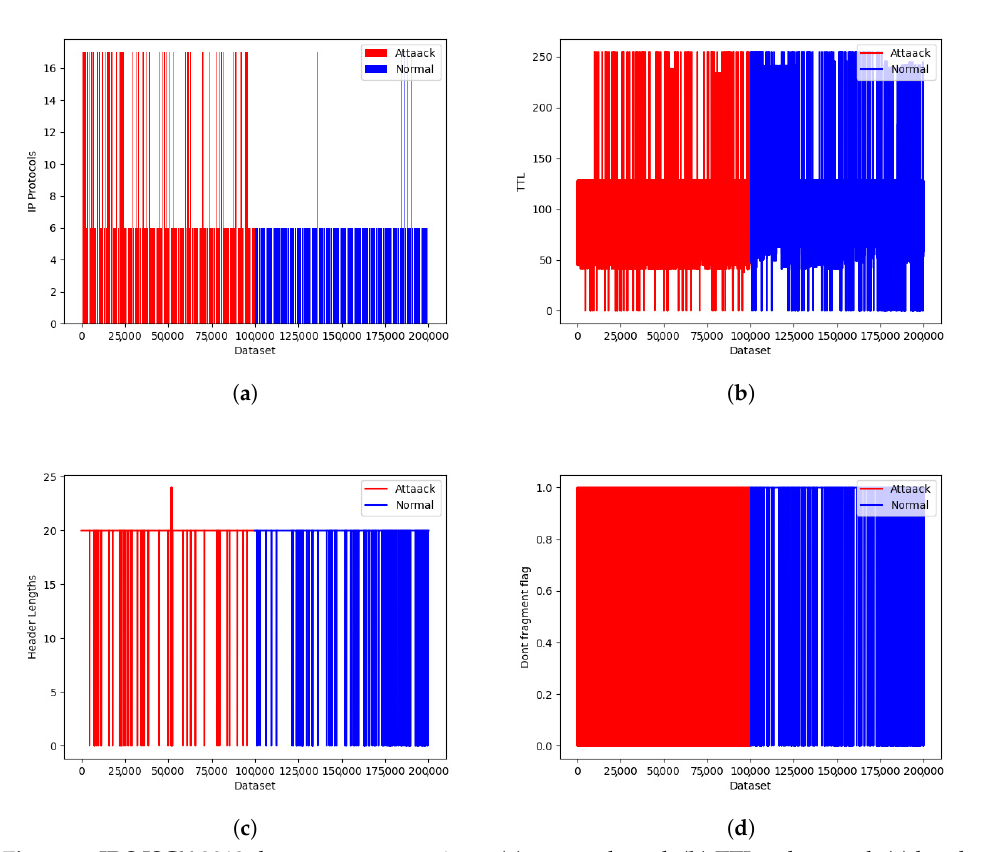
Figure 7. IDS ISCX 2012 dataset representations: ( a ) protocol used; ( b ) TTL value used; ( c ) header length; and ( d ) Don’t Fragment